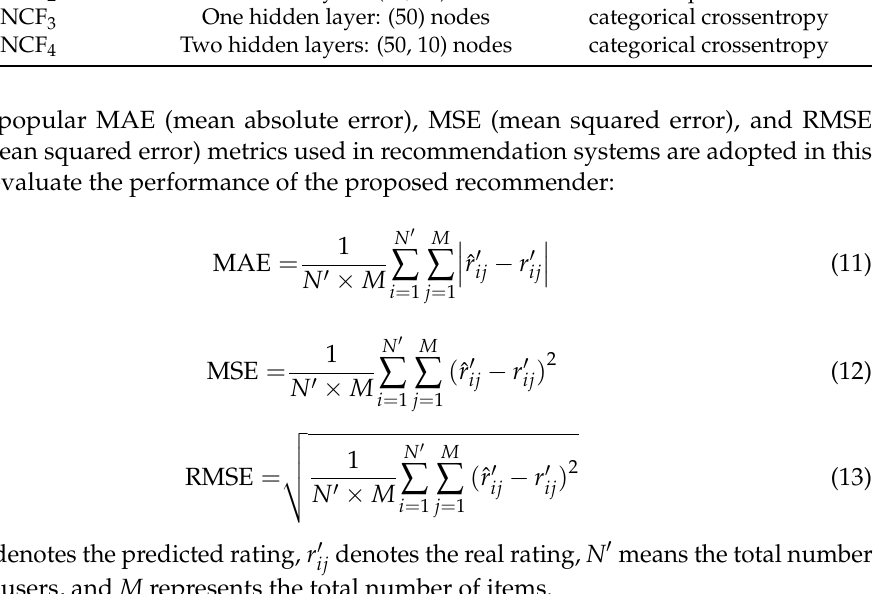
Table 5. The architecture and loss function used for each NNCF predictor. Model Architecture in MLP Layers Loss Function NNCF 1 One hidden layer: (50) nodes mean squared error NNCF 2 Two hidden layers: (50, 10) nodes mean squared error NNCF 3 One hidden layer: (50) nodes categorical crossentropy NNCF 4 Two hidden layers: (50, 10) nodes categorical